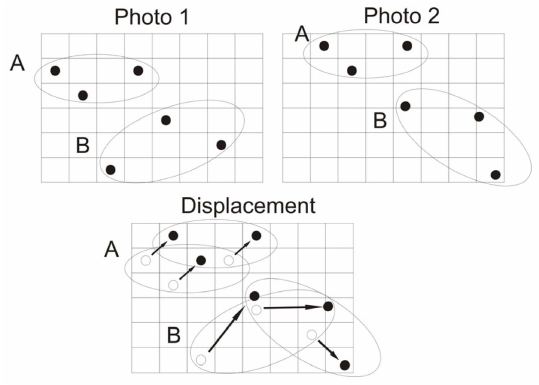
Figure 3. Particle displacement derived from the position captured in two different